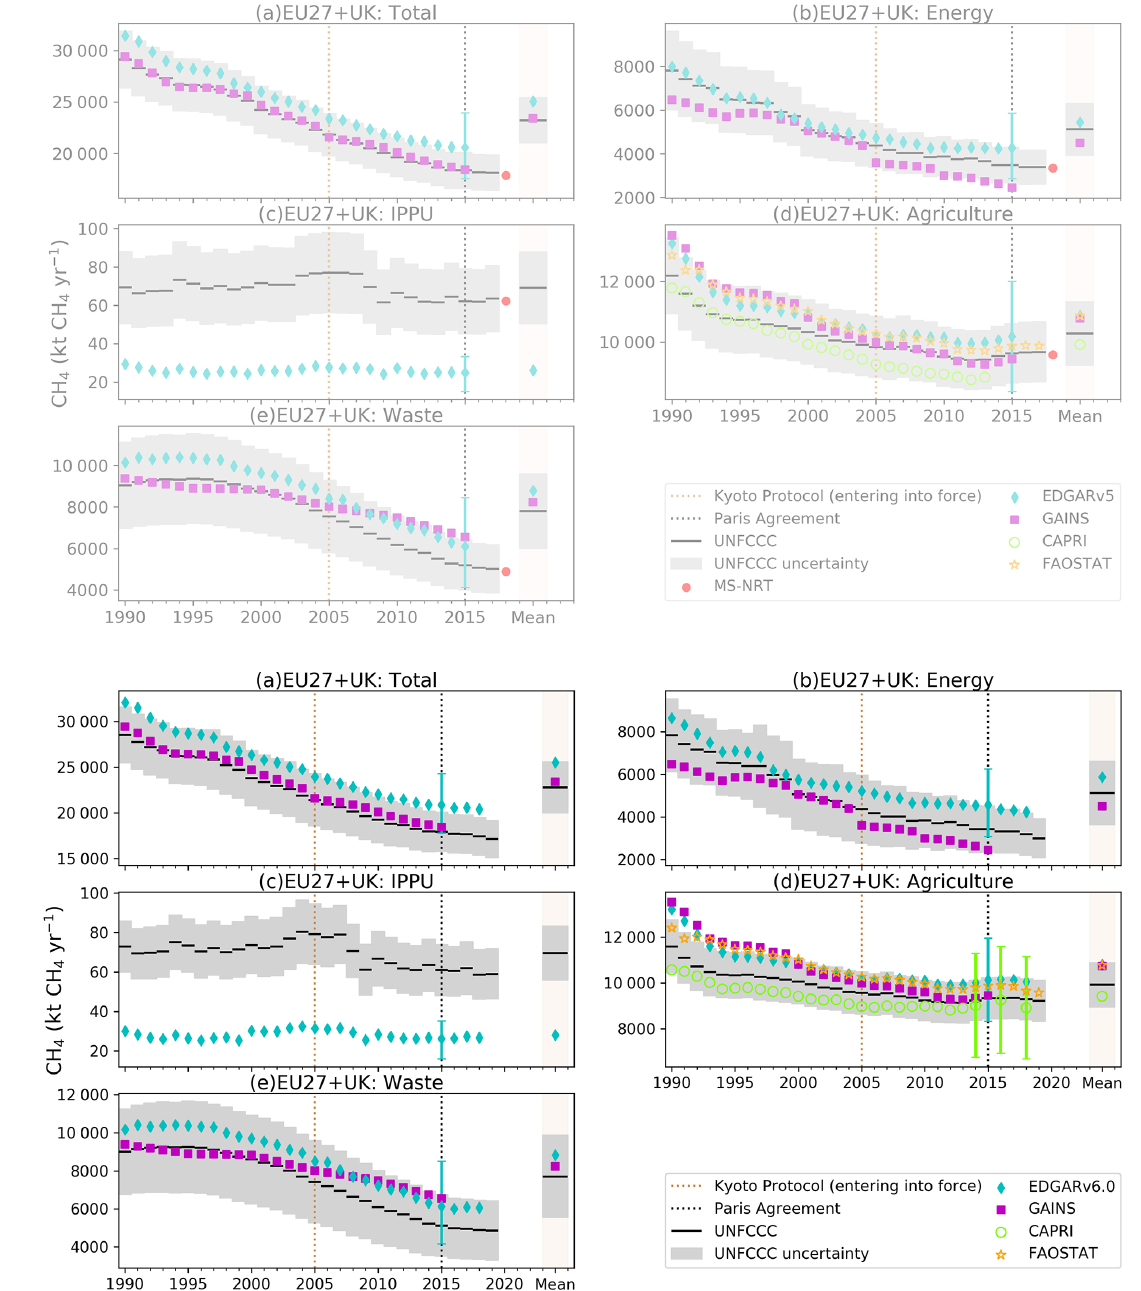
Figure 3. Total annual anthropogenic CH 4 emissions (excluding LULUCF) for the EU27 + UK over time. The top plot presents previous data synthesized in Petrescu et al. (2021), while the bottom plot shows data synthesized by the current study: (a) EU27 + UK and total sectoral emissions from (b) energy, (c) industrial processes and product use (IPPU), (d) agriculture, and (e) waste from UNFCCC NGHGI (2021) submissions compared to global bottom-up inventory models for agriculture (CAPRI, FAOSTAT) and all sectors excluding LULUCF (EDGARv6.0, GAINS). CAPRI reports one estimate for Belgium and Luxembourg. The relative error on the UNFCCC value represents the UNFCCC NGHGI (2021) member-state-reported uncertainties computed with the error propagation method (95% confidence interval) that were gap-filled and provided for every year. The uncertainty for EDGARv6.0 is the same as that of v5.0 and calculated for 2015 as min/max values for the total and each sector (Solazzo et al., 2021) and represents the 95% confidence interval of a lognormal distribution. The mean column represents the common overlapping periods between datasets: 1990–2015 for total EU27 + UK, energy, agriculture and waste; 1990–2018 for IPPU; and 1990–2014 for CAPRI. The last years of the time series of the respective datasets are 2018 (EDGARv6.0, CAPRI), 2019 (FAOSTAT, UNFCCC) and 2015 (GAINS). After 2014 CAPRI delivered estimates for 2 additional years, 2016 and 2018, as well as uncertainties for 2014 and 2018 (25.1%) and 2016